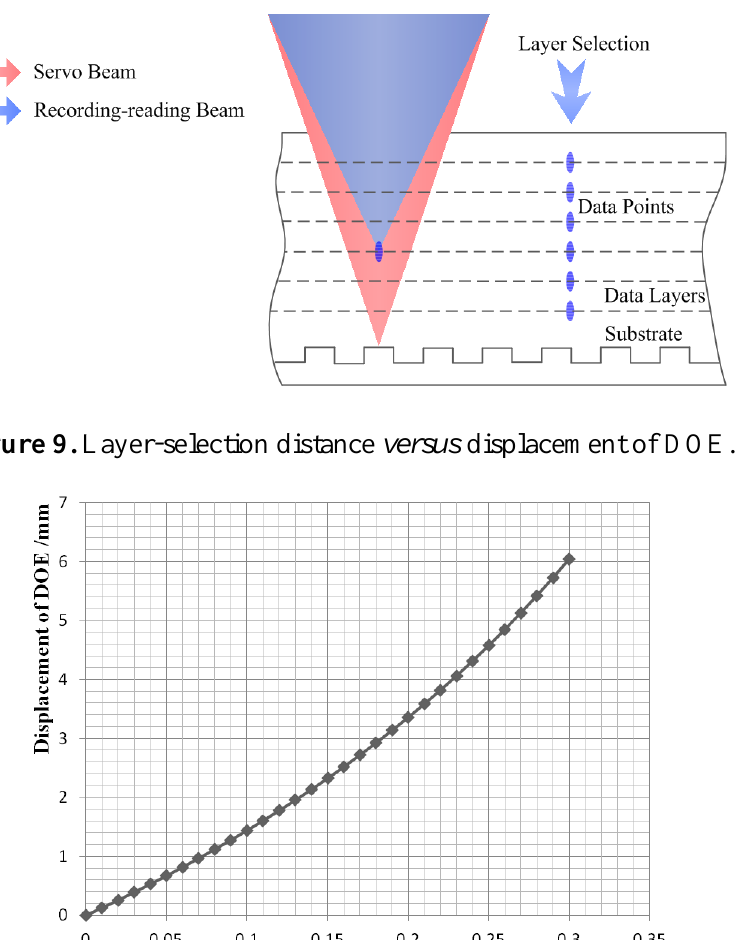
Figure 8. Layer-selection process.